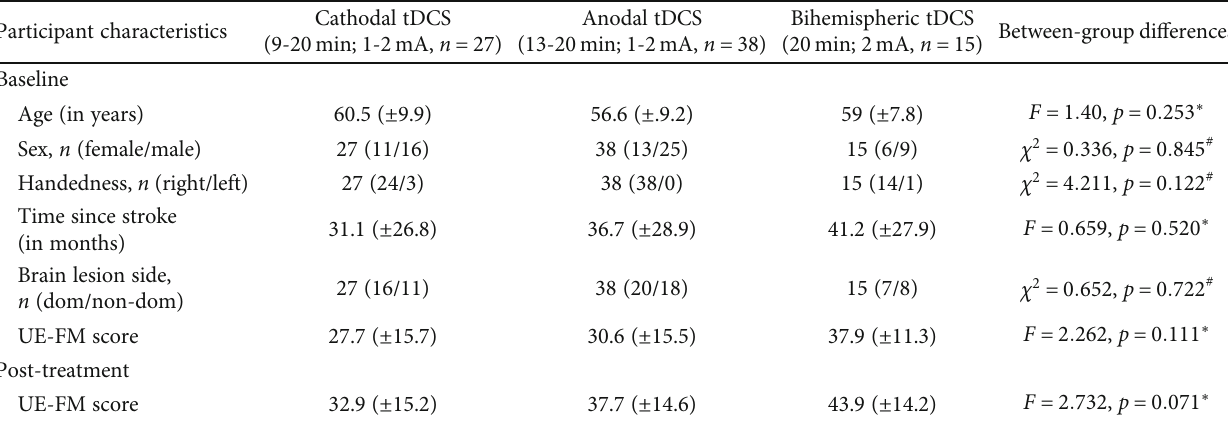
Table 1: Clinical and demographic characteristics.